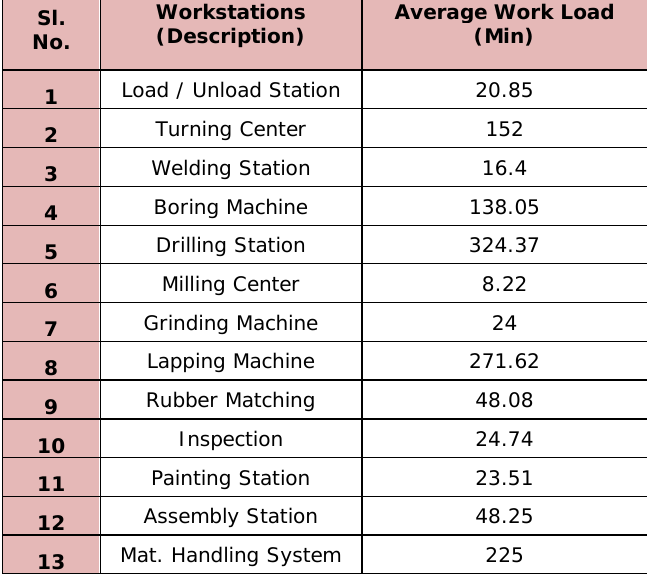
Table 2. “Average Workload on Workstations”. Source: Own contribution